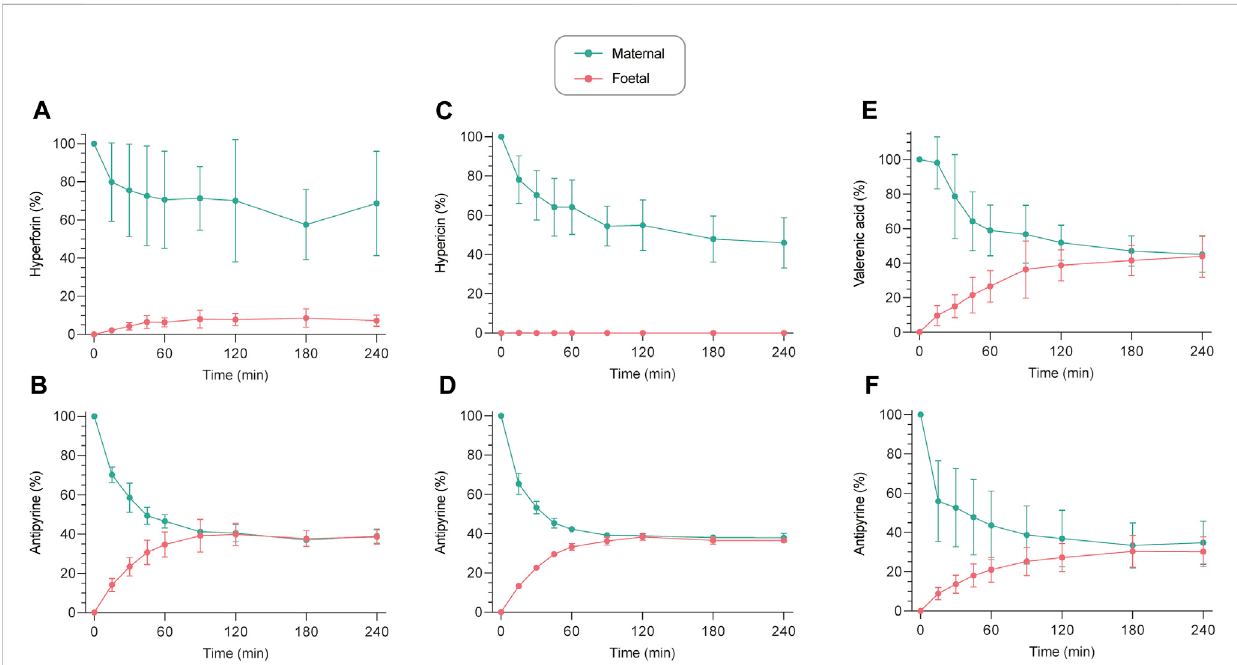
FIGURE 2 Ex vivo human placental perfusion pro fi les of hyperforin (A) , hypericin (C) , and valerenic acid (E) with corresponding connectivity controls (antipyrine) ( (B,D,F) , respectively). Concentrations are expressed as a percentage (%) of the initially analyzed concentration in the maternal sample. All values are expressed as mean ± SD of three to four independent experiments. Perfusion pro fi les with absolute concentrations (ng/mL) can be found in Supplementary Figure S1.